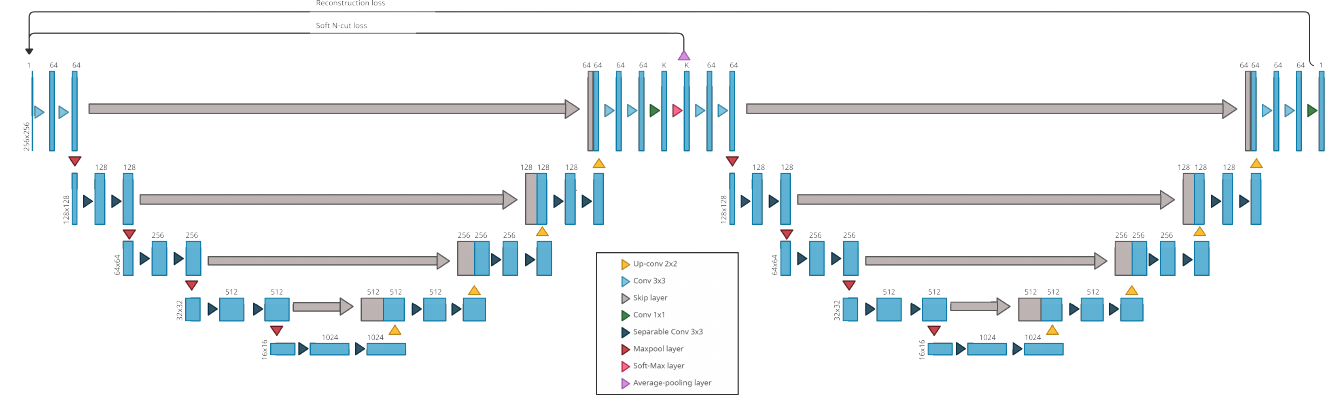
Figure 2. Our W-net architecture for ARMD lesions